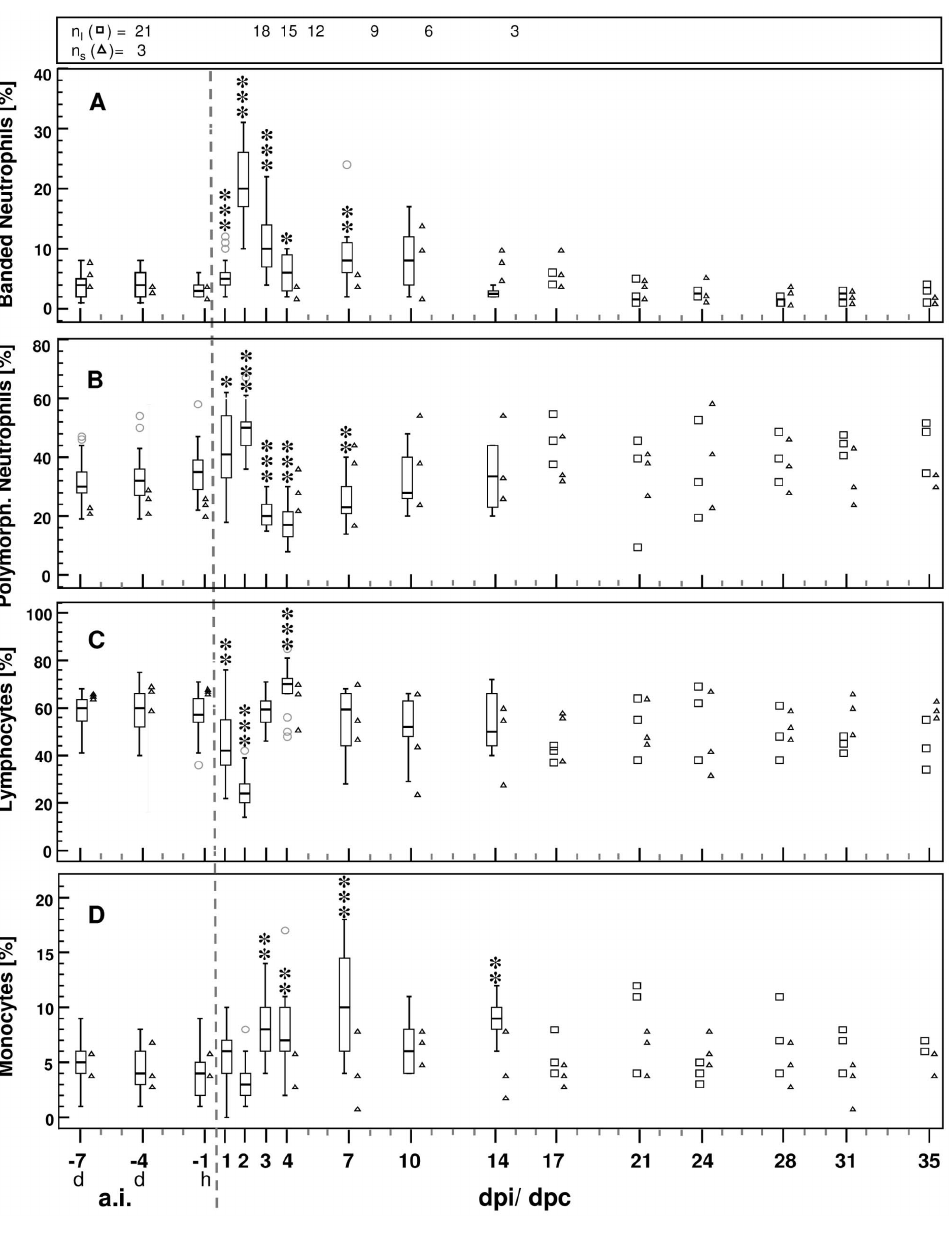
Figure 4. Relative amounts of white blood cells before and after C.psittaci challenge. Compared to baseline data, both banded and polymorphnuclear neutrophils increased during the acute phase of infection whilst lymphocytes decreased transiently. Based on the group size of calves inoculated with 10 8 ifu/animal (n I ) data are given as Box and Whisker plots or as individual data (squares, if n # 3), respectively. For statistical analysis, baseline data (averaged per animal) were compared to data obtained at different time points after challenge (Wilcoxon signed-rank test). Values of * P # 0.05, ** P # 0.01, and *** P # 0.001 were considered significant. Outlier values are indicated by small grey circles. Due to small sample size of sentinel calves (n S, triangles) no statistical hypothesis was applied to this group. a.i ante infectionem . d day. dpi days post inoculation. dpc days post contact to inoculated calves. h hour.